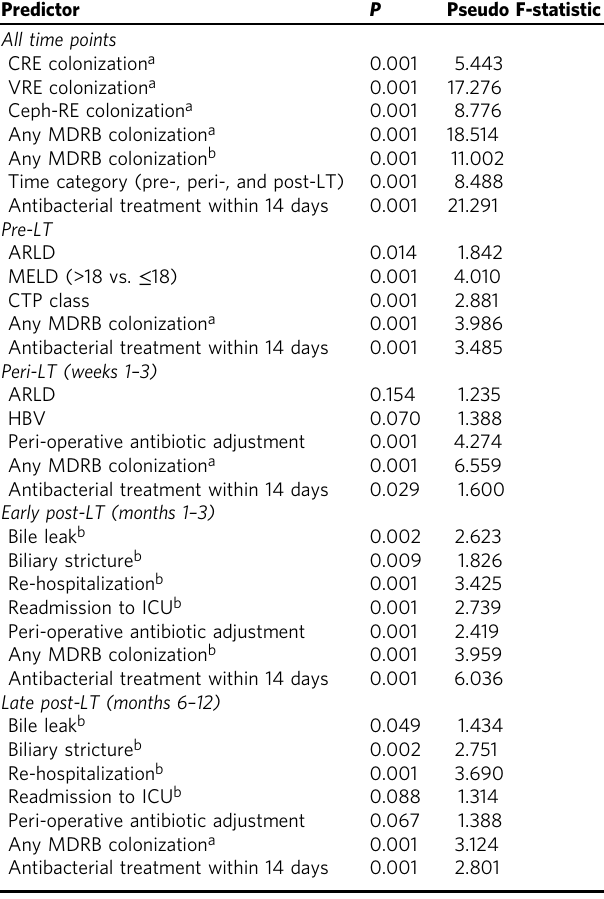
Table 4 Clinical and microbial predictors associated with gut microbiome UniFrac β -diversity before and after liver transplantation using PERMANOVA